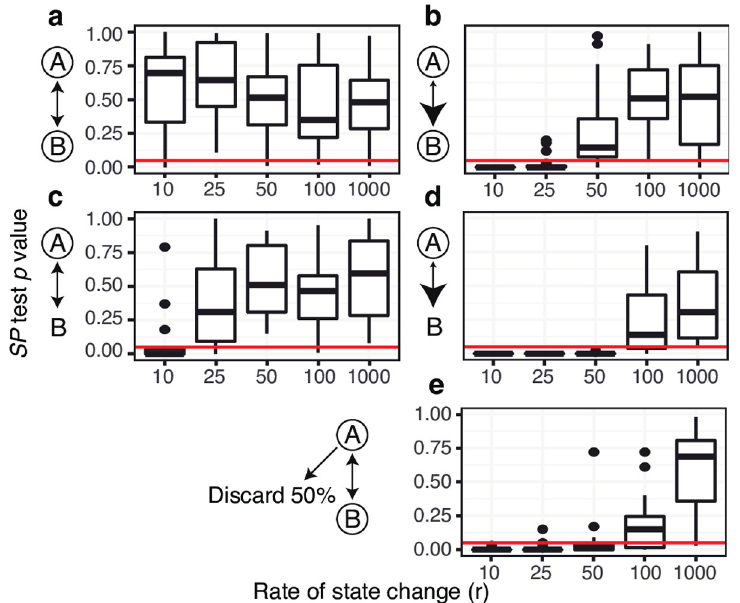
Fig 2. Distribution of SP test p values from A to B from two state simulation analyses in which state change between state A and B was determined by the probability of starting in A ( π a ), relative rate of migrating from A to B ( r ab ), and the average rate of state change ( r ). To the left of each plot, possible starting states are circled, relative rates are shown by arrowhead size. (a) π = 0.5, r = 1, fully unbiased state change, shows roughly uniform a ab distribution of p values at all tested rates. (b) π a = 0.5, r ab = 10 shows low p values at rates < 50. (c) π a = 1, r ab = 1 shows low p values at low rates (10) but not at higher rates. (d) π = 1, and r = 10 shows low p values at rates < 100. (e) π = a ab A 0.5, r ab = 1 shows low p values at rate < 50 if 50% of A sequences are discarded. Compared to (a) , this shows that p values are sensitive to biased sampling of sequences. Red lines show the cutoff of p value = 0.05.